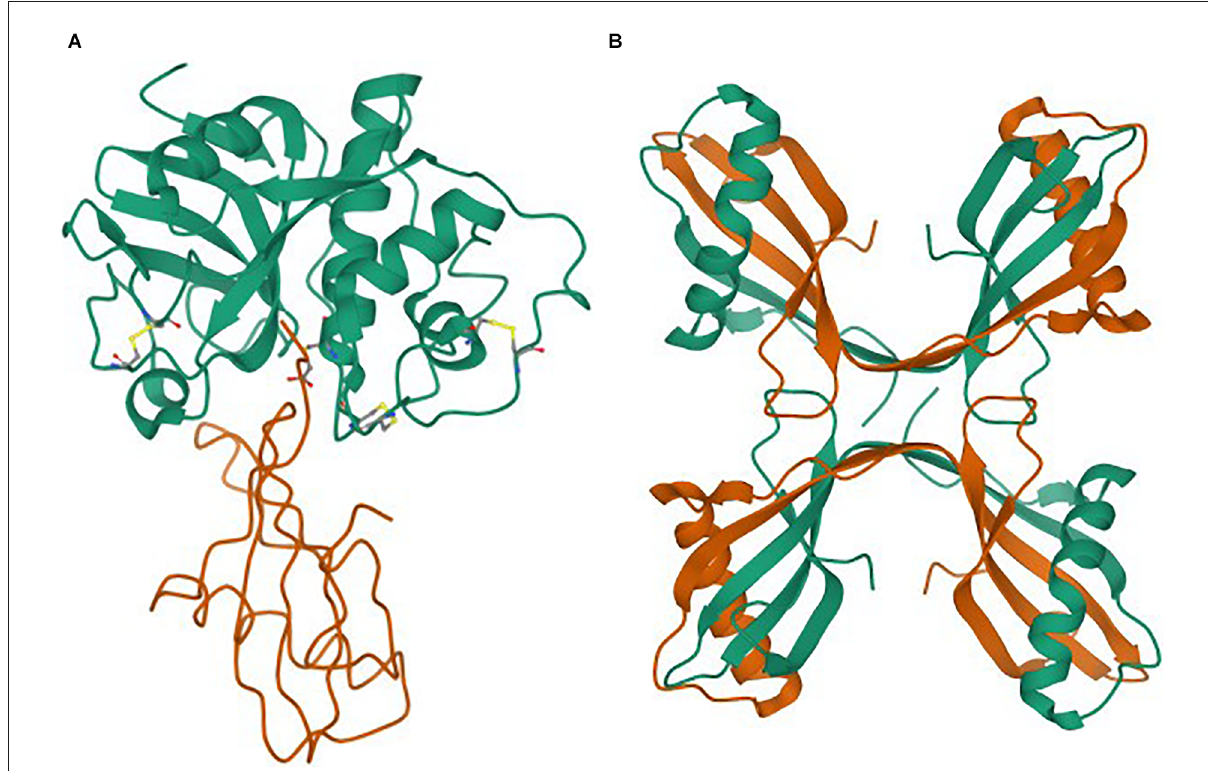
FIGURE1 (A,B) Structures as taken from the Protein Data Bank (PDB). (A) Monomer of stefin B in complex with papain (Stubbs et al., 1990). (B) Tetramer of stefin B (Jenko Kokalj et al.,